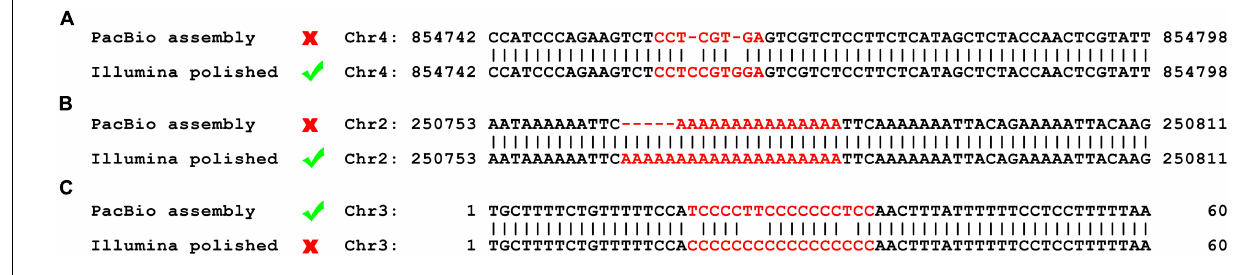
FIGURE 1 | Errors in PacBio data and Illumina data. The errors in the low complexity and short tandem repeat (STR) regions can be corrected during the genome polishing using Illumina data, while the errors in the long ( > 10 G or C) poly(GC) regions need be curated using PacBio data after the genome polishing. (A) An example to show that the assembled genomes using high-depth PacBio data still contain errors in the low complexity regions. (B) An example to show that the assembled genomes using high-depth PacBio data still contain errors in the STR regions. (C) An example to show that the genome polishing using Illumina data causes errors in the long poly (GC) regions.